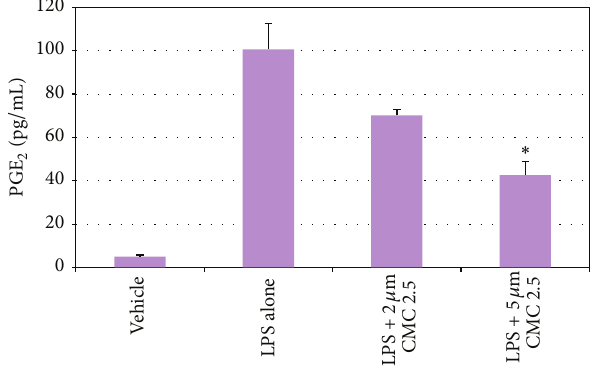
Figure 3: Inhibition of PGE 2 levels by CMC 2.5 in PBMC cells. PBMC cells (5 × 10 5 cells/well) were cultured in serum-free media (37 ∘ C, 95% air, 5% CO 2 ) for 18 hours with LPS ( P. gingivalis , 50 ng/mL) or vehicle alone. CMC 2.5 was added at final concen- trations of 2 or 5 𝜇 M. Conditioned medium was analysed for PGE 2 by ELISA. Each value represents the mean of 3 cultures ± S.E.M. ∗ 𝑃 < 0.05 .